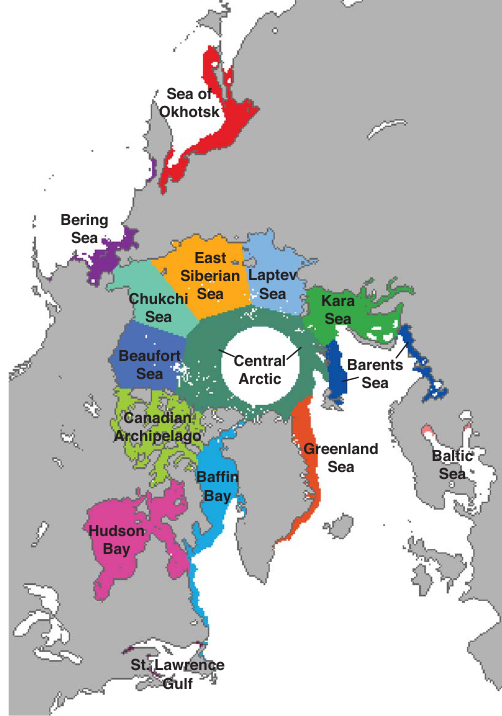
Figure 2. Melt onset date 34-year climatology and region map. White pixels indicate open water locations and locations where a MO date is not calculated for 1 or more years in the 34-year clima- tology. Different colors indicate the Arctic subregions used in this